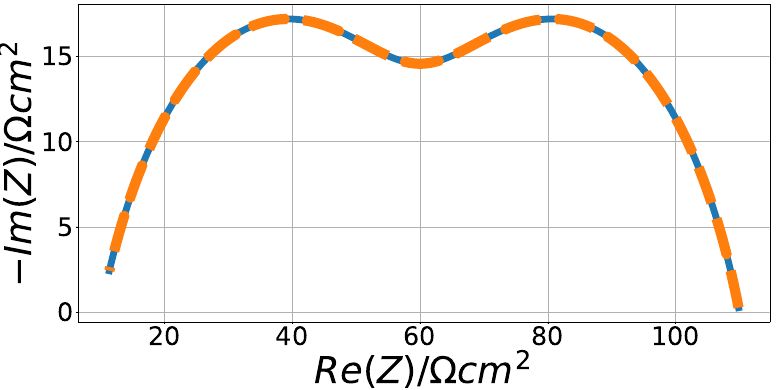
Figure 13. The result of fitting the synthetic data obtained using the Cole–Cole equation (i.e., ZARC elements).